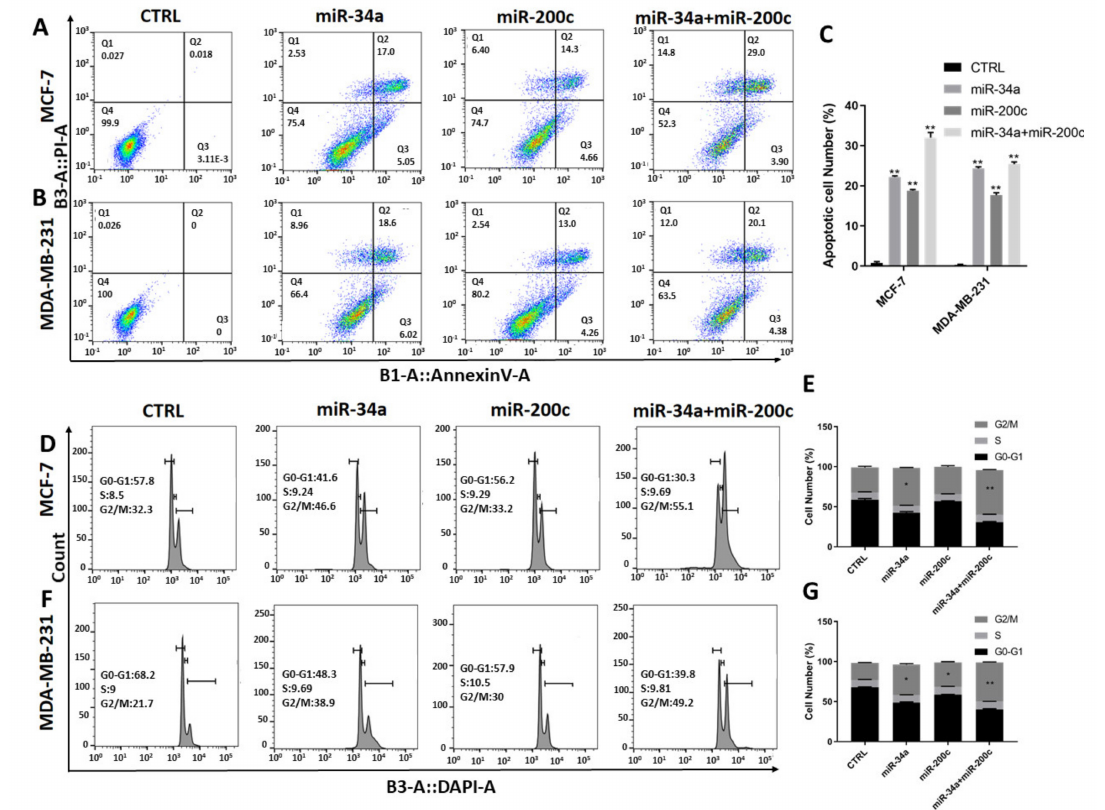
Figure 2. Exogenous miR-34a and miR-200c expression additionally induce apoptosis and G 2 /M cell cycle arrest. ( A – C ) Annexin V/propidium iodide assays following transfection of miR-34a, miR-200c and the combination in MCF-7 and MDA-MB-231 breast cancer cell lines. ( D , E ) Cell cycle profiles and respective quantifications of MCF-7, and ( F , G ) and MDA-MB-231 cells stained with DAPI and subjected to flow cytometry. Abbreviations: *, p -value < 0.05; **, p -value <